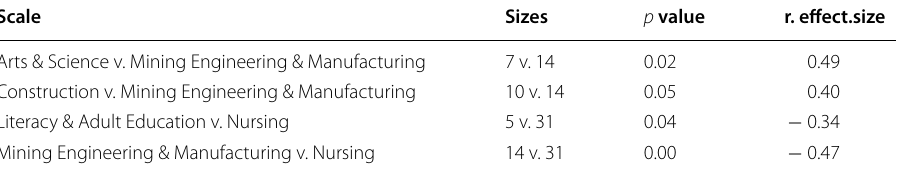
Table 5 Significant comparisons for the total mentorship culture audit scale between schools in 2019 Scale Sizes p